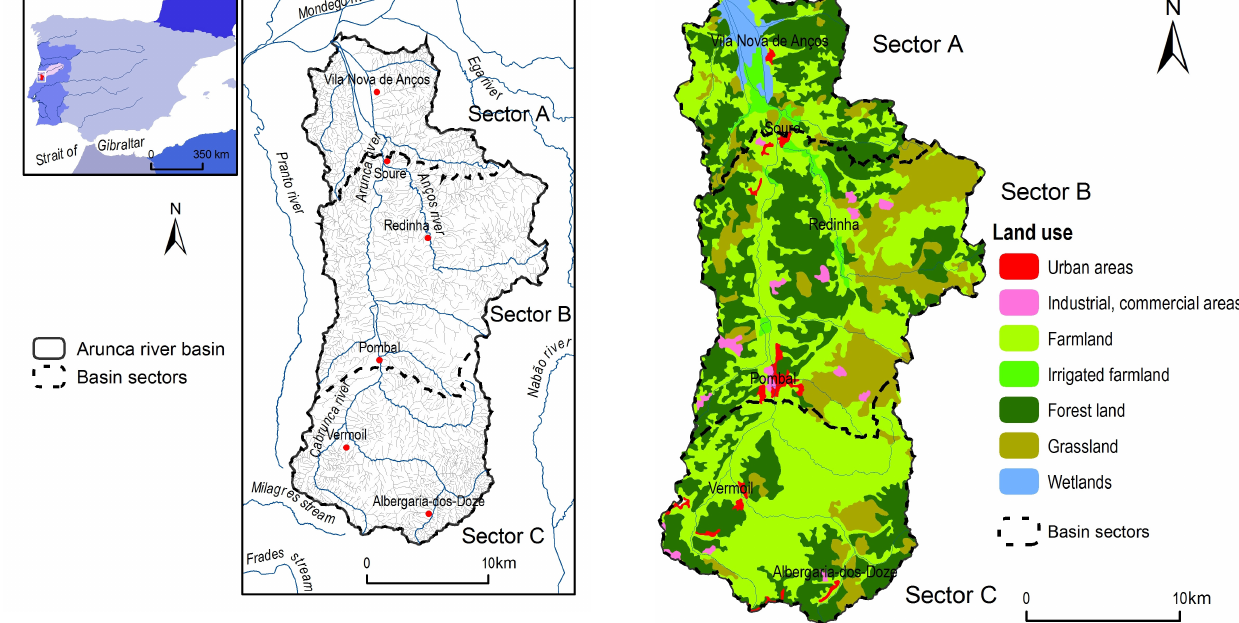
Fig. 2. Arunca River basin land